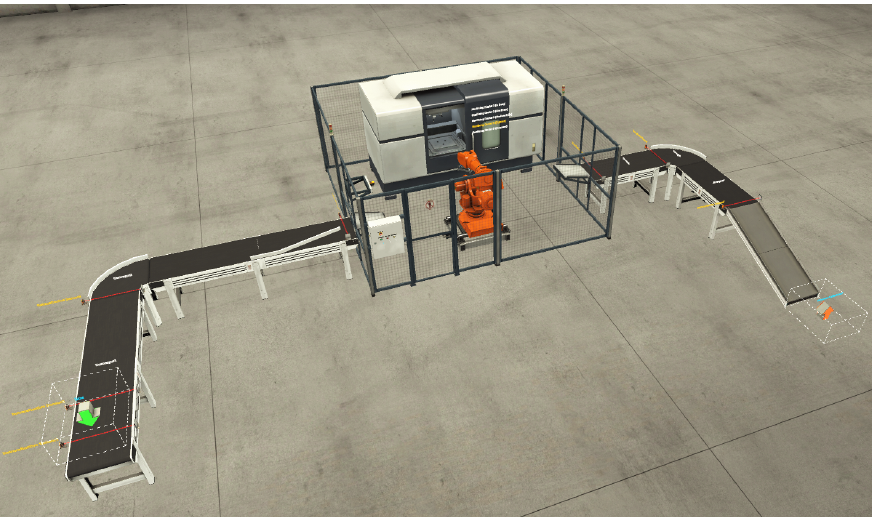
Figure 4. Overall view of the virtual production line.